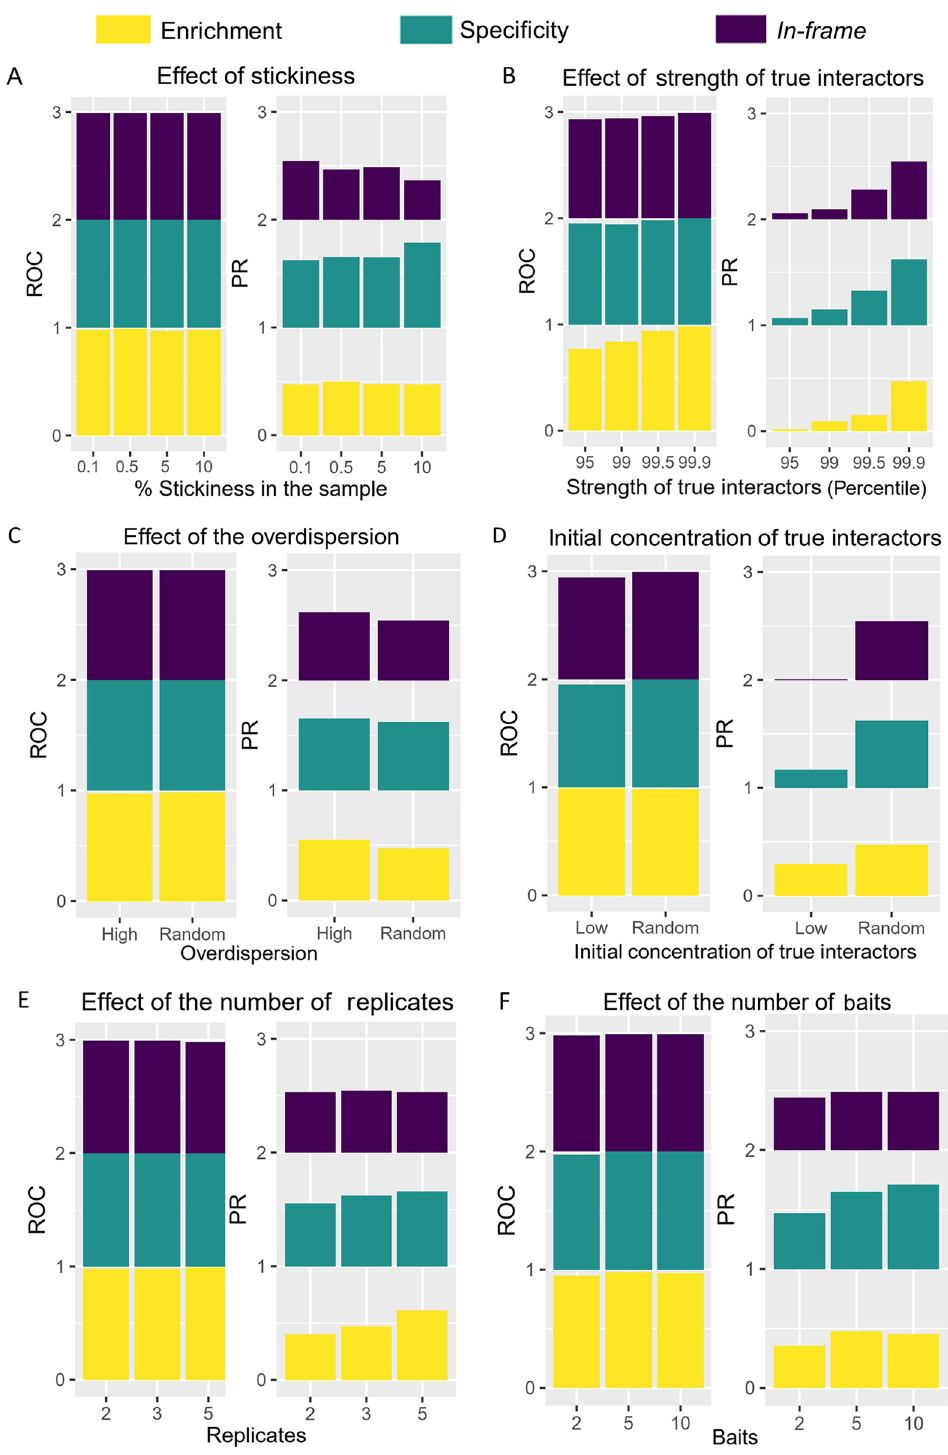
Fig 4. Effect of changes in the parameters that define Y2H-NGIS simulation. Examples of challenging scenarios were simulated to determine the Y2H-SCORES classification power. A) Stickiness (percentage of auto-active/non-specific preys in the library), B) Strength of true interactors, C) Overdispersion, D) Concentration of true interactors in the prey library, E) Number of replicates, and F) Number of baits. Receiver Operating Characteristic (ROC) and Precision Recall (PR) AUC values were reported for the enrichment, specificity, and in-frame